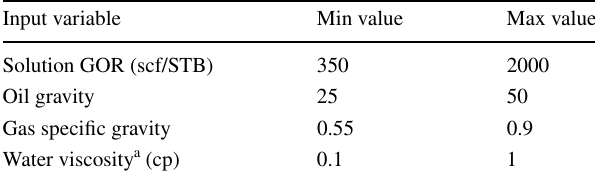
Table 3 PVT input variables sensitivity